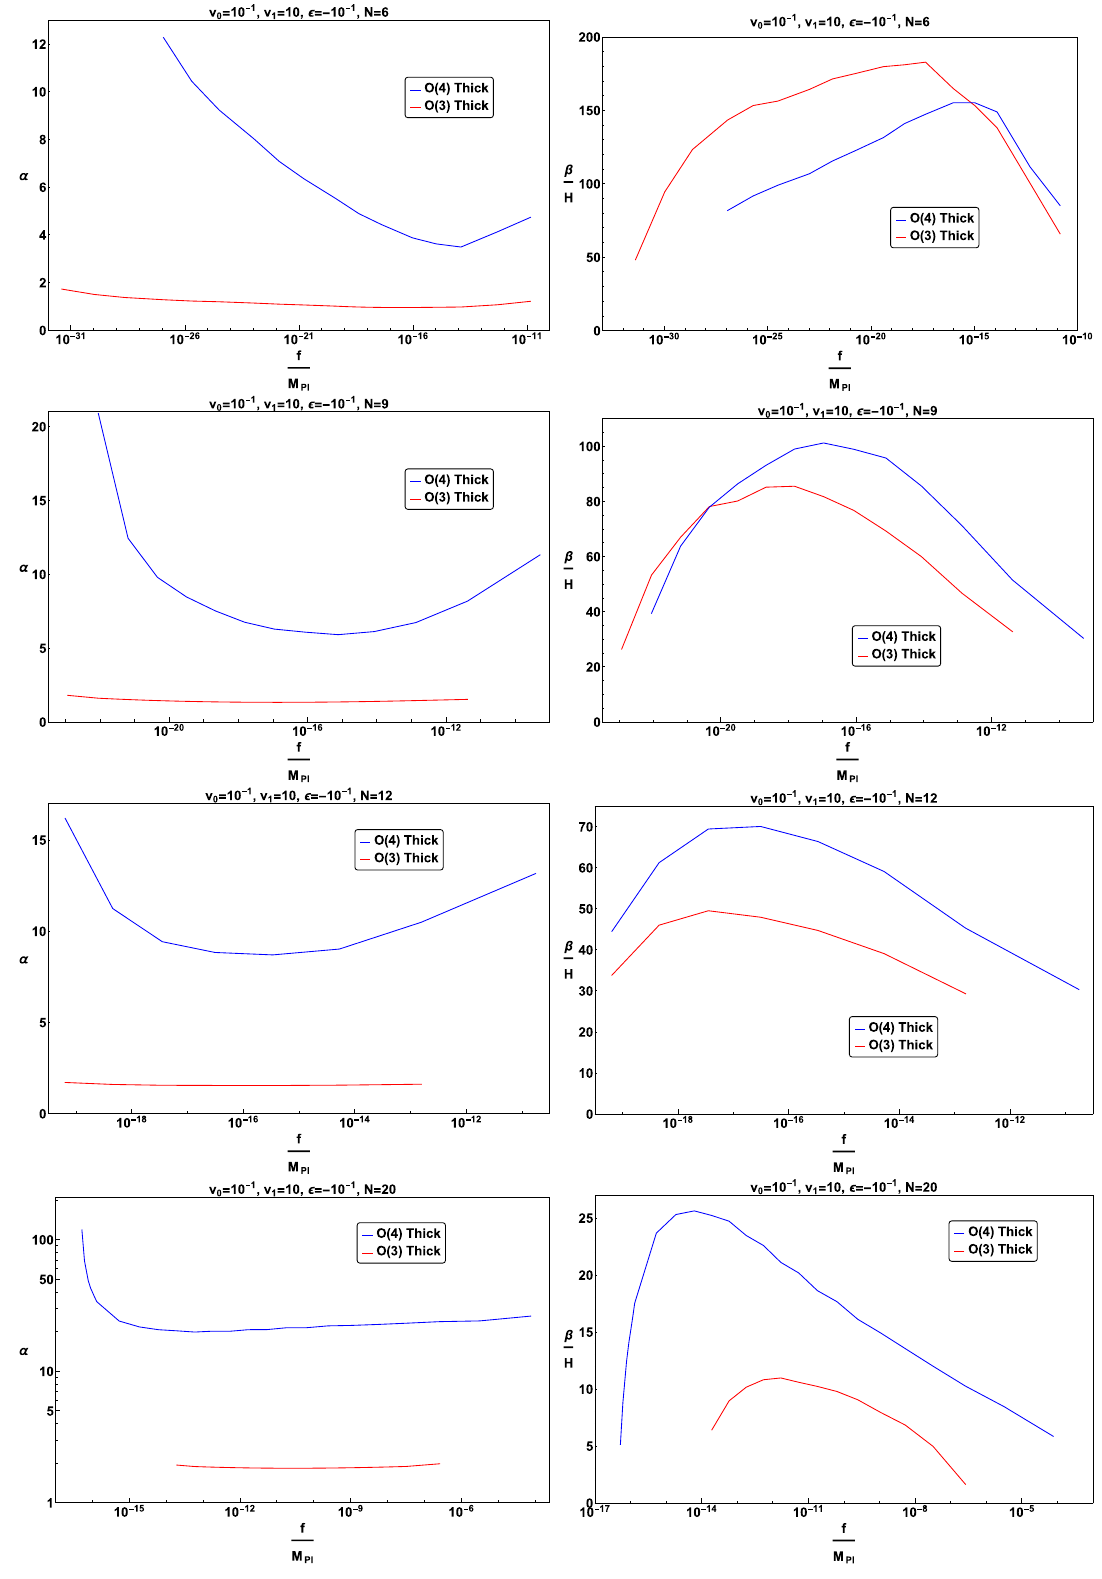
Fig. 9 These plots display the parameters α and β for a range of N as a function of the hierarchy between f and M Planck at the minimum of the zero-temperature potential after the cosmological phase transition completes. Both O ( 3 ) and O ( 4 ) bubbles are